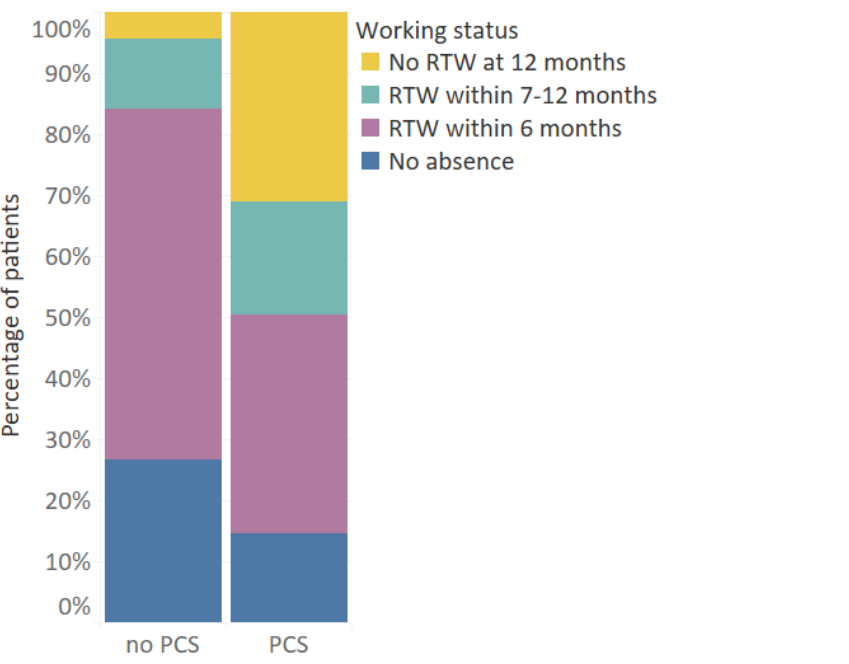
Figure 5. Return to work rates for patients aged 18–67 who had paid employment pre-injury ( n = 770), by PCS status. PCS: Post-concussion syndrome ( ≥ 3 of the core post-concussion symptoms).